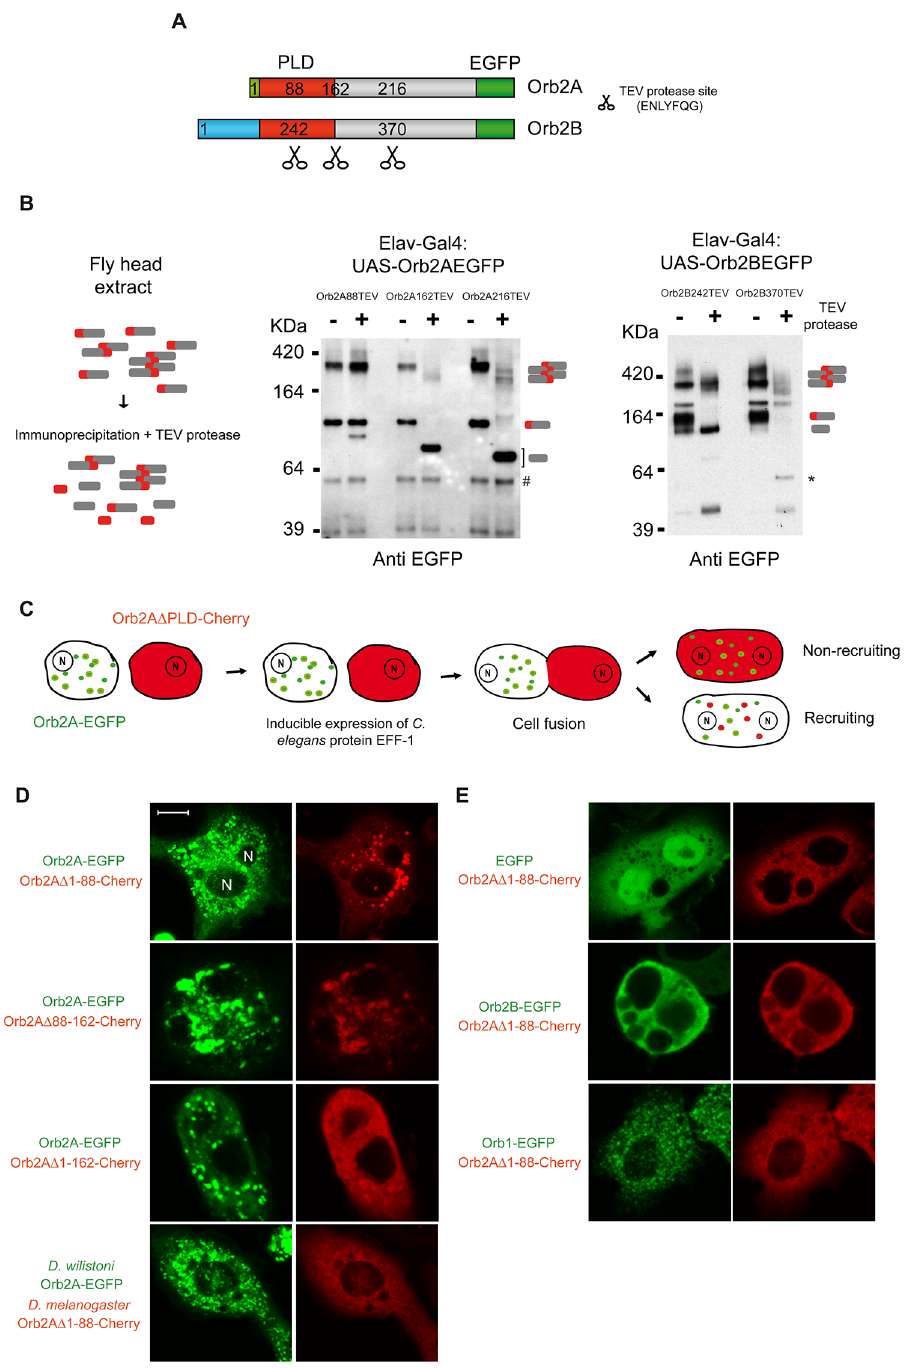
Fig 2. Organization of the Orb2 PLD. (A) . Schematic representation of the location of the TEV protease recognition motif (ENLYFQG) inserted into Orb2. (B) EGFP-tagged Orb2A and Orb2B bearing TEV protease sites were expressed pan-neuronally, and immunopurified Orb2 was treated with TEV protease for 24 h. The left panel shows the schematic of the experiment. The cleaved C-terminus of different sizes derived from Orb2A are indicated with a bracket. The * indicates an EGFP reactive polypeptide most likely originated from degradation of the cleaved Orb2B370TEV C-terminus. (C) Schematic diagram of the epithelial fusion failure 1 (EFF-1) cell fusion “ cytoduction ” experiment in S2 cells. The expected outcomes in terms of the recruitment or nonrecruitment of oligomers are indicated. (D) Residues 88 to 162 are sufficient for recruitment into pre- existing oligomers. Full-length Orb2A-EGFP induced the Orb2A construct lacking the 88 N-terminal